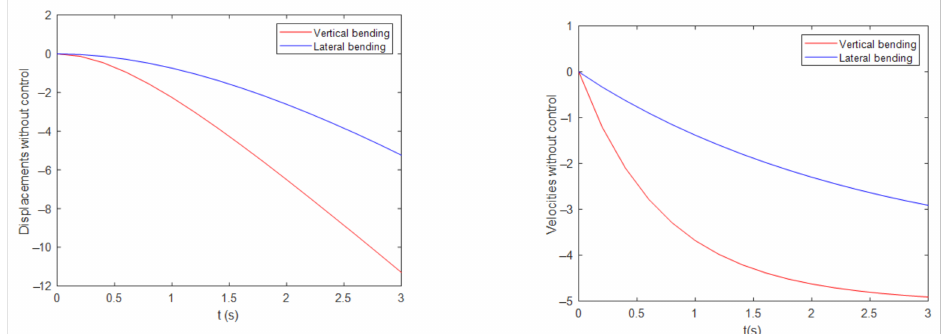
Figure 3. The uncontrolled blade sectional displacements’ responses and velocities’ responses under wind speed U = 5 m s − 1